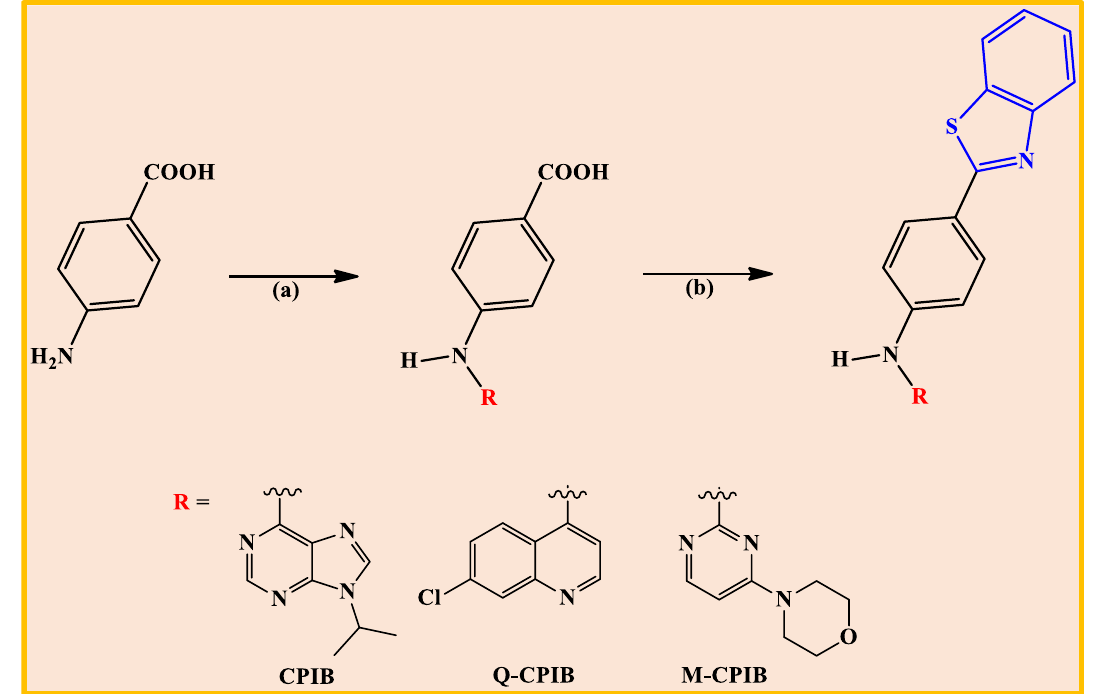
Figure 2. Scheme for synthesis. Reagents and Conditions: (a) R-Cl, 150 °C for 1 h in n-butanol. (b) 2-Aminothiophenol, polyphosphoric acid, 200 °C for 2 h.